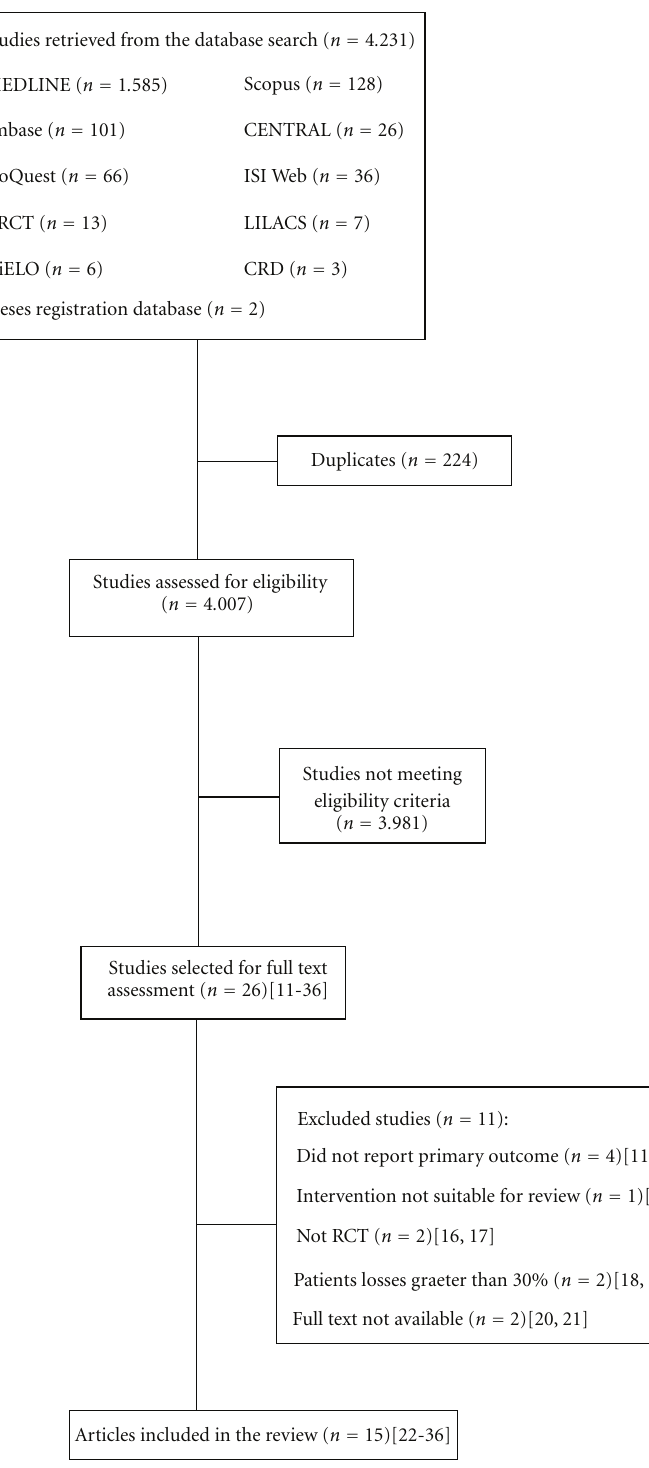
Figure 1: Flow chart of the search, selection, and inclusion of